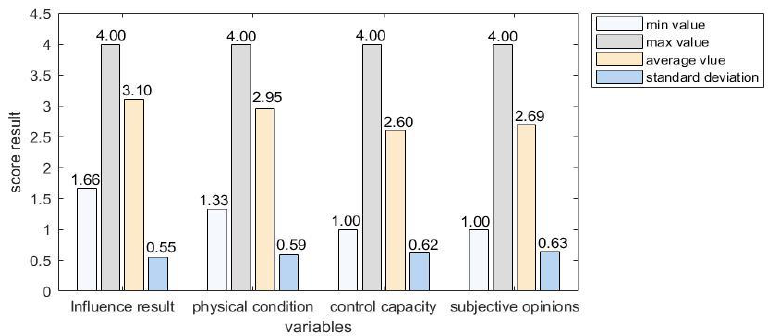
Figure 5. Results of the descriptive analysis.